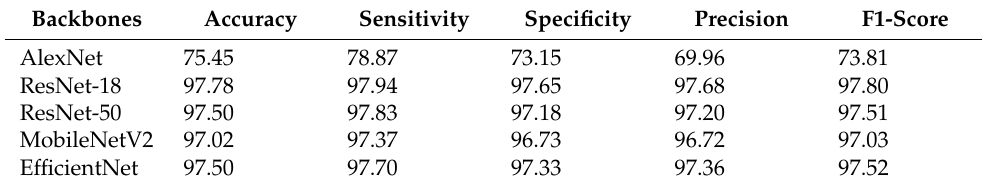
Table 5. Results of the CGENet using different backbones based on 5-fold CV. Backbones